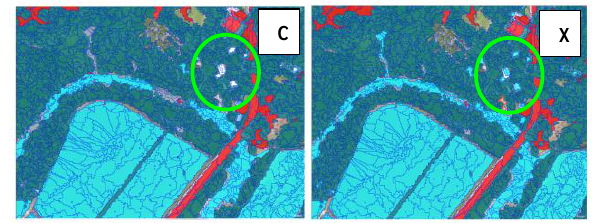
Figure 7. Water classification using assign class algorithm with mean CHM maximum threshold value of 0.2.